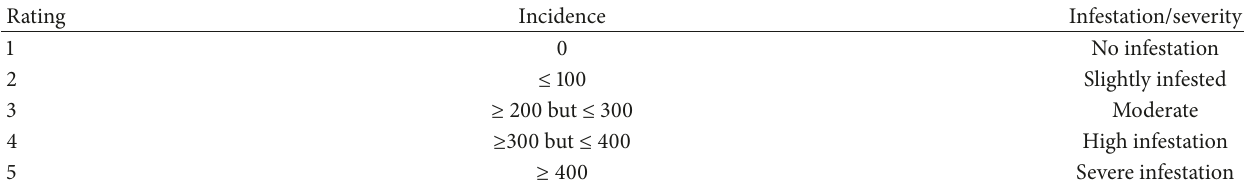
Table 1: Rating scale for aphid infestation and severity.